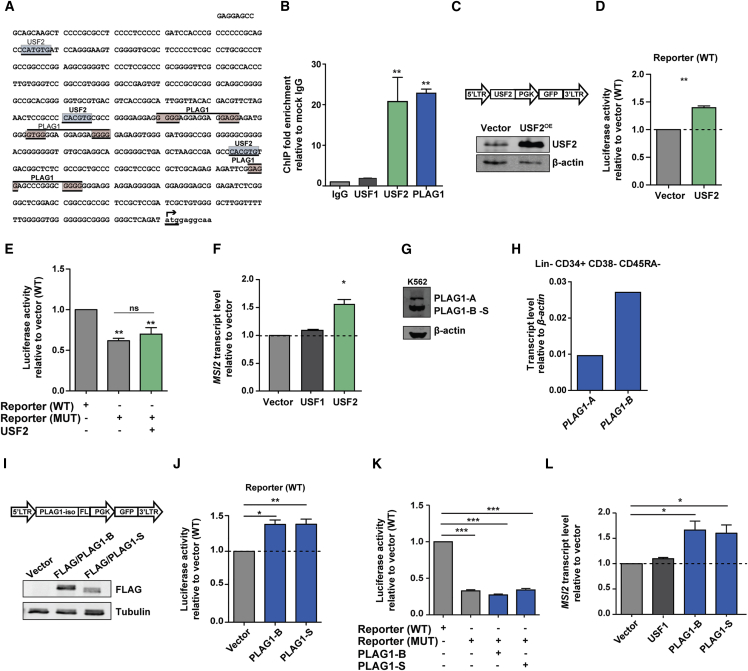
Ectopic PLAG1 and USF2 Bind the MSI2 Promoter and Enhance Its Transcription in K562 Cells(A) DNA sequence of the minimal promoter for MSI2 with predicted (MatInspector) USF2 (blue) and PLAG1 (red) binding sites shown. The translation start site of MSI2 is identified by the forward arrow from lower case nucleotides and the initiation codon is underlined.(B) ChIP-qPCR for PLAG1 and USF2 binding of the minimal MSI2 promoter (n = 4 experiments).(C) USF2-overexpressing lentiviral construct schematic (top) and western blot quantification of its enhanced protein levels in K562 cells (bottom).(D) Wild-type (WT) MSI2 minimal promoter reporter construct luciferase activity upon USF2 overexpression (n = 3 experiments).(E) Luciferase activity of USF2 binding site-mutated (MUT) reporter with and without USF2 overexpression compared with WT (n = 4 experiments).(F) Endogenous MSI2 transcript levels following USF2 overexpression in K562 cells (n = 3 experiments).(G) Characterization of PLAG1 isoform expression by western blot in K562 cells.(H) Comparison of PLAG1-A and PLAG1-B expression in flow-sorted CB HSPCs (performed once from pooled CB samples).(I) FLAG-tagged PLAG1 short-isoform overexpressing lentiviral construct schematic and western blot quantification of enhanced protein levels in K562 cells (bottom).(J) WT reporter construct luciferase activity upon PLAG1-B or PLAG1-S overexpression (n = 4 experiments).(K) Luciferase activity of PLAG1-B and PLAG1-S MUT reporters with PLAG1-B or PLAG1-S overexpression compared with WT (n = 4 experiments).(L) Endogenous MSI2 transcript levels following PLAG1-B or PLAG1-S overexpression in K562 cells (n = 3 experiments).Data are presented as means ± SEM. ∗p < 0.05, ∗∗p < 0.01, ∗∗∗p < 0.001. See also Figure S1 and Table S3.